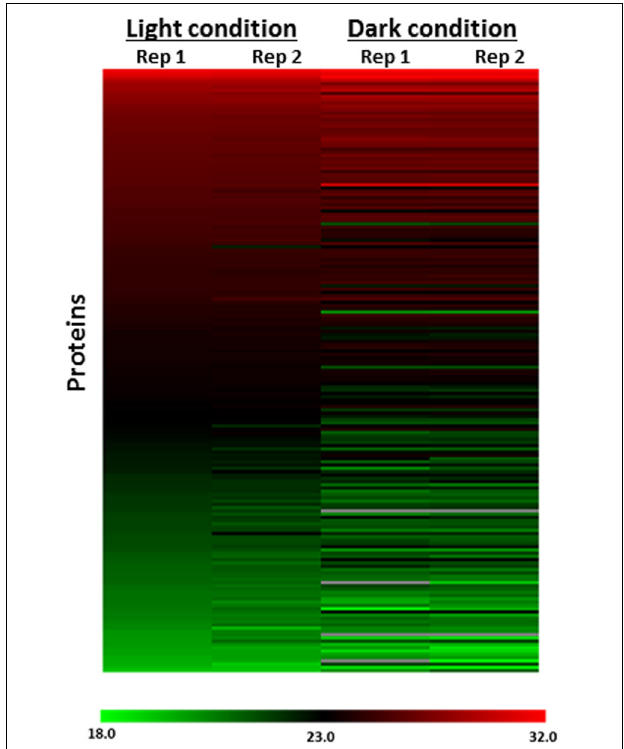
FIGURE 3 | Heat map representation of protein abundance profiles of 185 of 300 probe-labeled proteins designated as redox-sensitive identified in global (probe-free) LC-MS analysis. The heat map shows increased probe labeling after incubation in the dark relative to the light condition in live-cell labeled Synechococcus 7002 exhibited by redox sensitive proteins is independent of protein abundance changes. Rep1, Replicate 1; Rep2, Replicate 2. Scale represents log2 of protein abundance and ranges from low (green) to high (red) protein